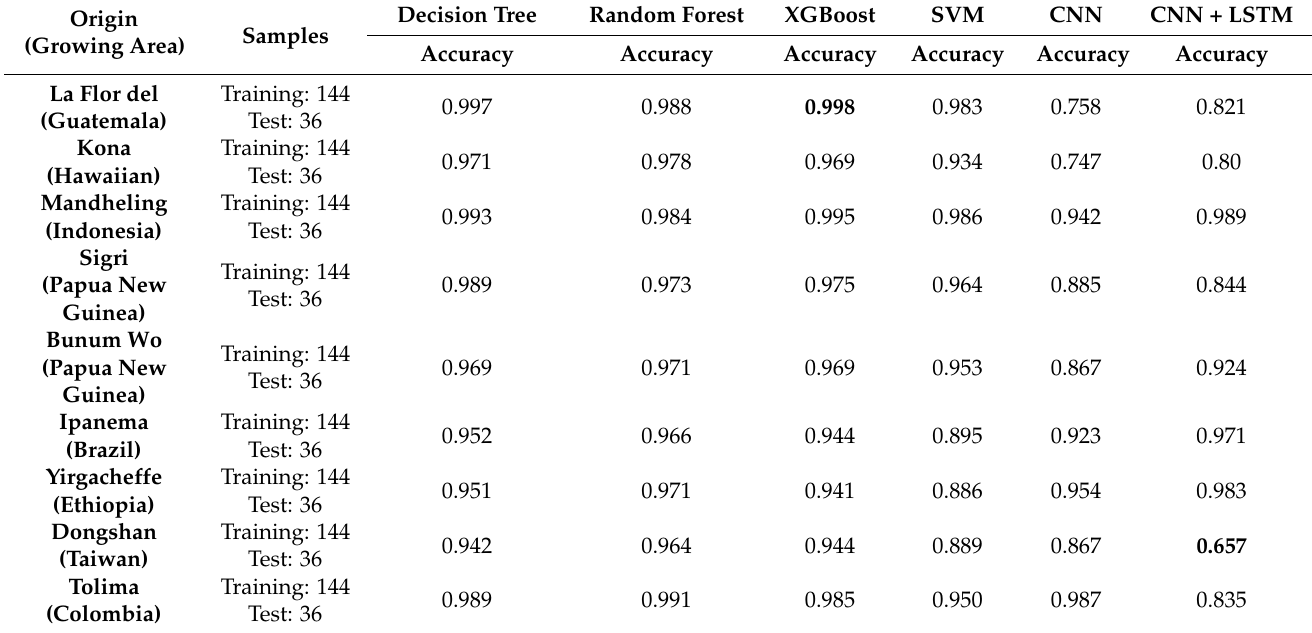
Table 2. Classifier performance results in scenario using 2-class predictions (experiment 1).